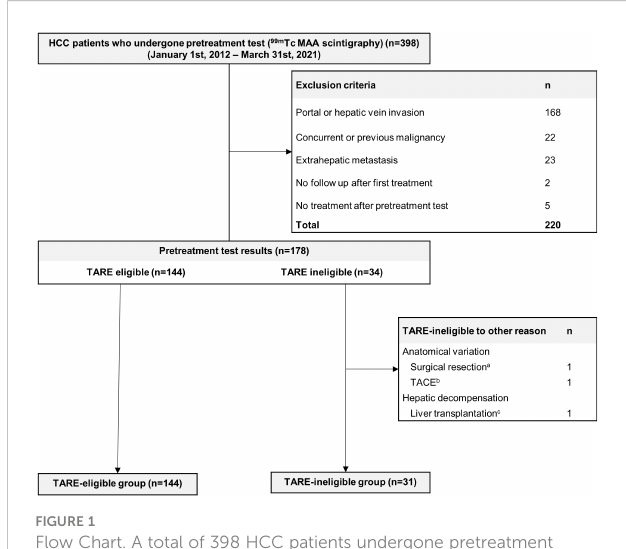
FIGURE 1 Flow Chart. A total of 398 HCC patients undergone pretreatment 99mTc MAA scintigraphy and 223 patients were excluded. A total of 175 patients were analyzed. a The patient underwent a right posterior sectionectomy and caudate lobectomy due to the dif fi culty in targeting HCC (HCC feeding artery branched from pancreatic artery). b TACE was performed on patient due to anatomical variance (left hepatic artery branching from left gastric artery causing dif fi cult to target). c Due to poor liver function, the patient received salvage living donor liver transplantation (Child-Pugh score 10). 99m Tc, technetium- 99m; HCC, hepatocellular carcinoma; MAA, macroaggregated albumin; TACE, transarterial chemoembolization; TARE, transarterial